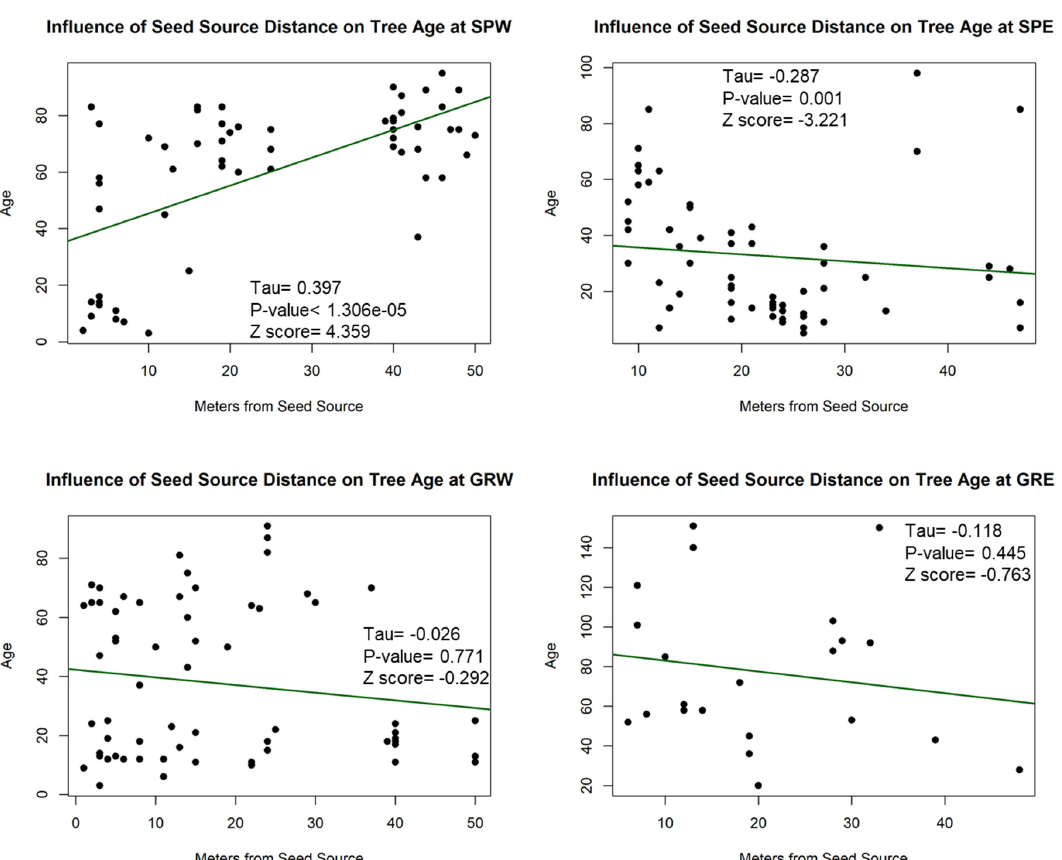
Figure 12. The relationship between tree age and distance from seed source at the individual transects. There are significant patterns in the relationship between tree measurements and the age of the tree. We chose to use a logarithmic transformation on the basal area and the height of the trees because after running the correlation without the log transformation there was a still a pattern in the residual plot (Figure A6). There are strong positive corre- lations between the age of trees and both their height and basal diameter (Figure 13) Figure 13. The relationship between log of basal diameter and tree age as well as log of height and tree age.